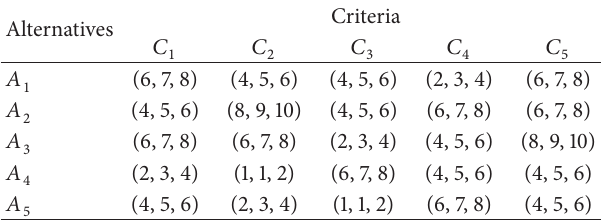
Table 3: Individual fuzzy decision matrix of DM 1